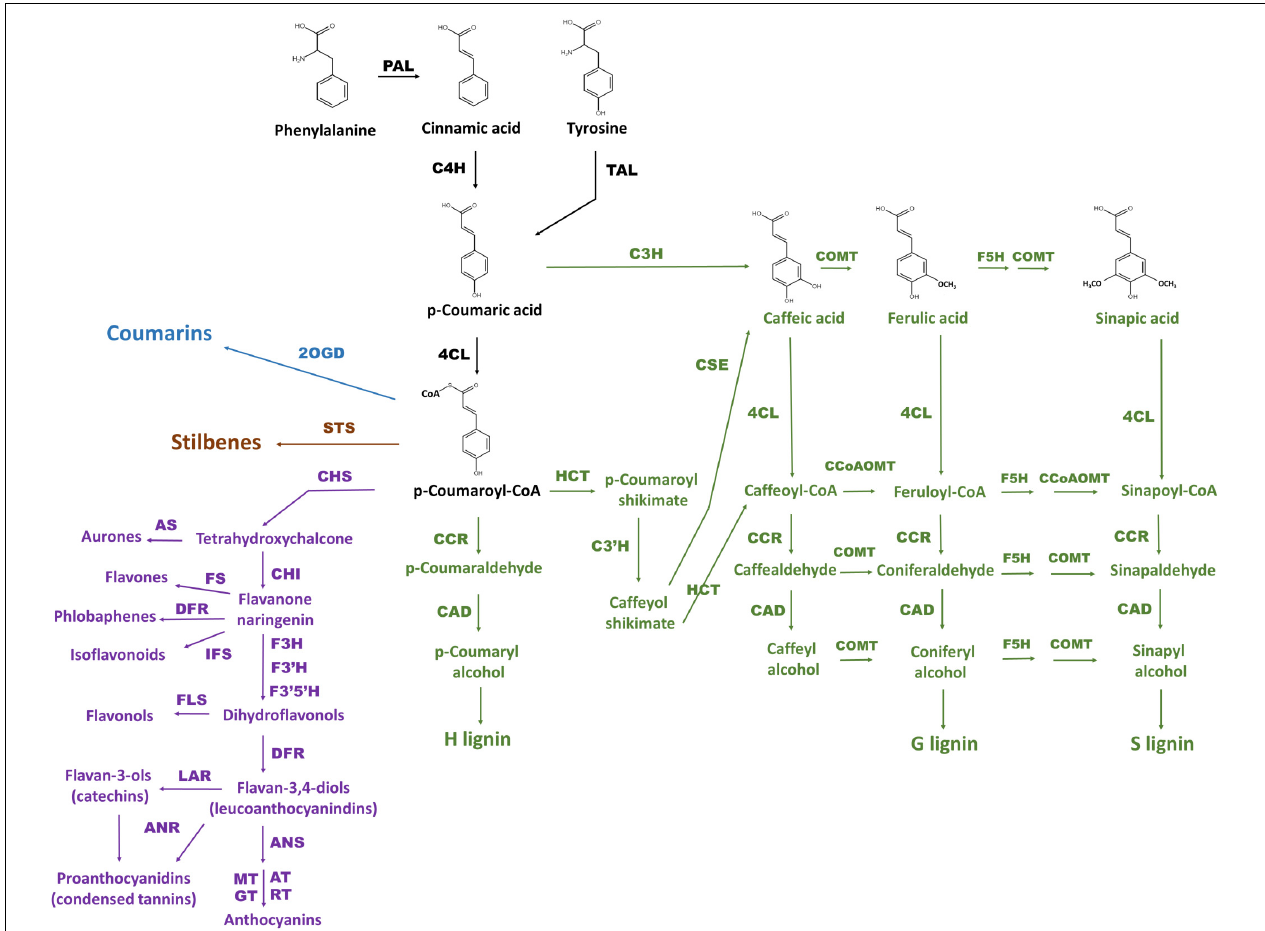
FIGURE 1 | The scheme of phenylpropanoid biosynthesis including pathway branches for flavonoids (purple), lignins (green), stilbenes (brown), and coumarins (blue) according to Deng and Lu (2017) and Marchiosi et al. (2020). General phenylpropanoid pathway reactions are black. The enzymes are PAL: phenylalanine ammonia lyase, C4H: cinnamate 4-hydroxylase, 4CL: 4-coumarate CoA ligase, HCT: hydroxycinnamoyl CoA:shikimate hydroxycinnamoyl transferase, C3H: p -coumaroyl shikimate 3-hydroxylase, C3 (cid:48) H: 4-coumaroylshikimate/quinate 3 (cid:48) -hydroxylase, CSE: caffeoyl shikimate esterase, CCoAOMT: caffeoyl CoA O-methyltransferase, F5H: ferulate 5-hydroxylase, COMT: caffeic acid O-methyltransferase, CCR: cinnamoyl CoA reductase, CAD: cinnamyl alcohol dehydrogenase, CHS: chalcone synthase, CHI: chalcone-flavanone isomerase, AS: aureusidin synthase, F3H: flavanone 3-hydroxylase, FLS: flavonol synthase, FS: flavone synthase, F3 (cid:48) H: flavonoid 3/c-hydroxylase, F3 (cid:48) 5 (cid:48) H: flavonoid 3/c,5/c-hydroxylase, IFS: isoflavonoid synthase, DFR: dihydroflavonol 4-reductase, ANS: anthocyanidin synthase, AT: acetyltransferase, GT: glycosyltransferase, MT: methyltransferase, RT: rhamnosyltransferase, LAR: leucoanthocyanidin reductase, ANR: anthocyanidin reductase, STS: stilbene synthase, 2OGD: 2-oxoglutarate-dependent